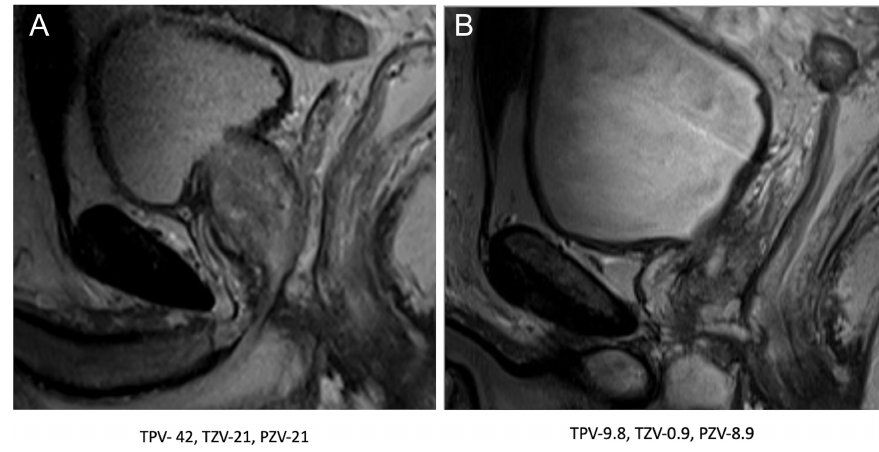
Figure 5. a,b. T-2 weighted images of prostate (coronal view) before and 2 month after HoLEP procedure (volume in